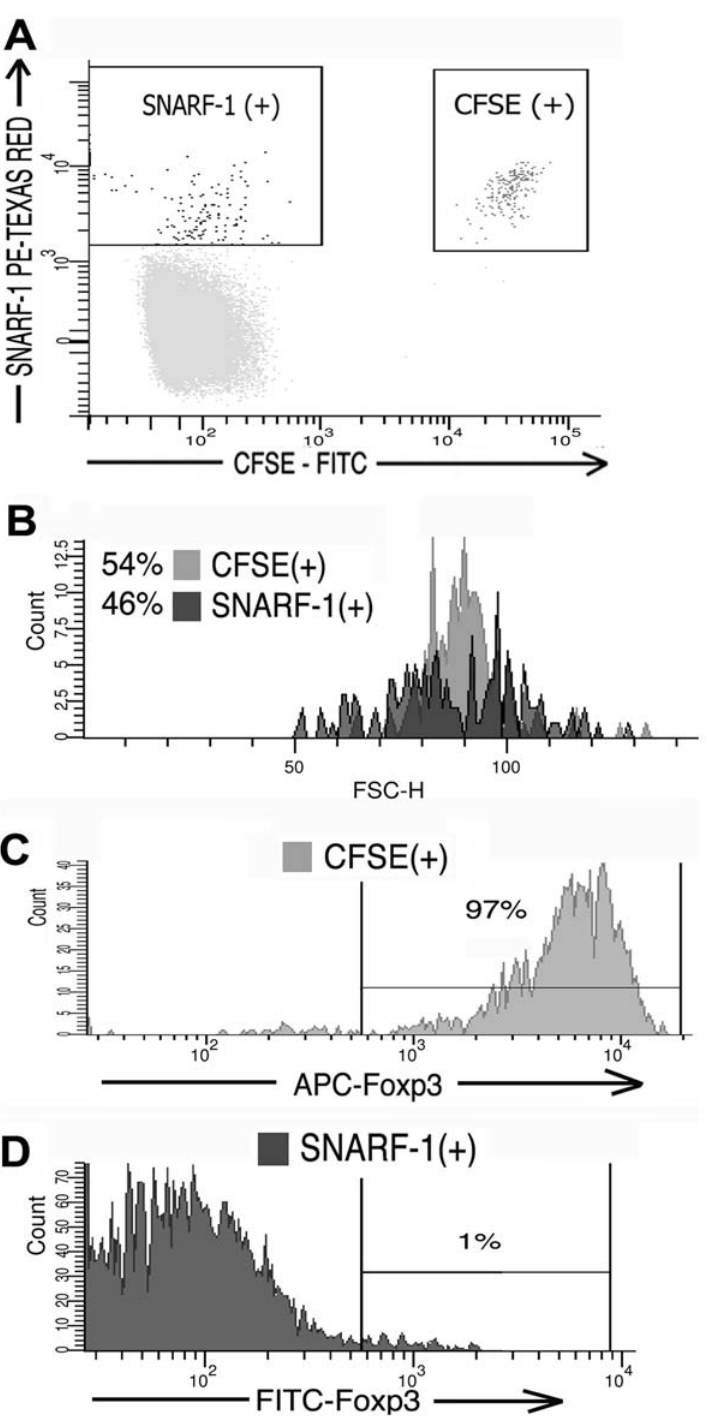
Figure 7. Invivo survival and proliferation of expanded T regs and T effs (independently injected into the same mouse) indicating impaired survival of T eff-conditioned is not intrinsic to all transferred T effs , but instead due to co-culture with T regs . A) CFSE + and SNARF-1 cells recovered four days following independent injections of expanded CFSE + CD4 + CD25 + cells (containing T regs and T eff-conditioned ) and expanded SNARF-1 + CD4 + CD25 2 T effs (unconditioned T effs ) demonstrating approximately equal survival of both populations ( , 0.4% of recovered lymphocytes each). The ratio of injected cells on Day 0 was 45% T regs , 10% T eff-conditioned , 45% unconditioned T effs . B) Histogram of recovered CFSE + and SNARF-1 + cells at day 4 demonstrate persistence of ‘‘unconditioned’’ T effs (SNARF-1 + cells) equivalent to survival of the CFSE + T reg /T eff-conditioned mix, a finding not observed when only T regs and T eff-conditioned are co-transferred (as shown in Figure 5). C–D) Foxp3 analysis of sorted cells demonstrating that surviving CFSE + cells are T regs (97% Foxp3 + ) and SNARF-1 + cells are ‘‘unconditioned’’ T effs (Foxp3 2 ), indicating impaired survival and proliferation of transferred T eff-conditioned is a consequence of co-culture with T reg during exogenous expansion (characteristic findings from 5 mice).